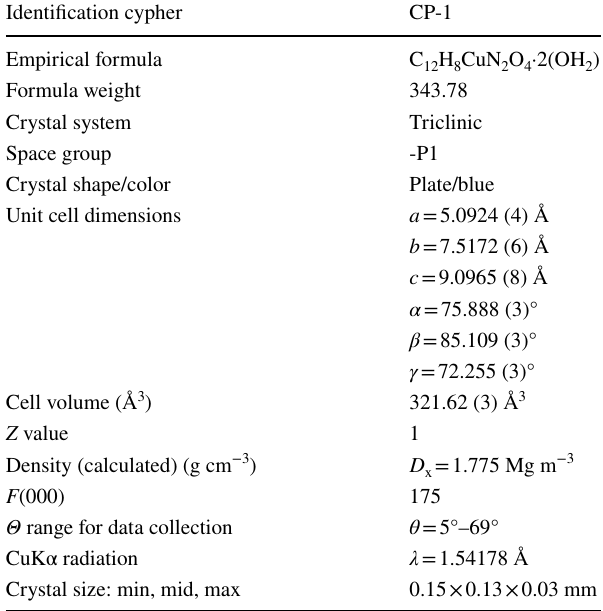
Table 1 Crystal structural data of CP-1